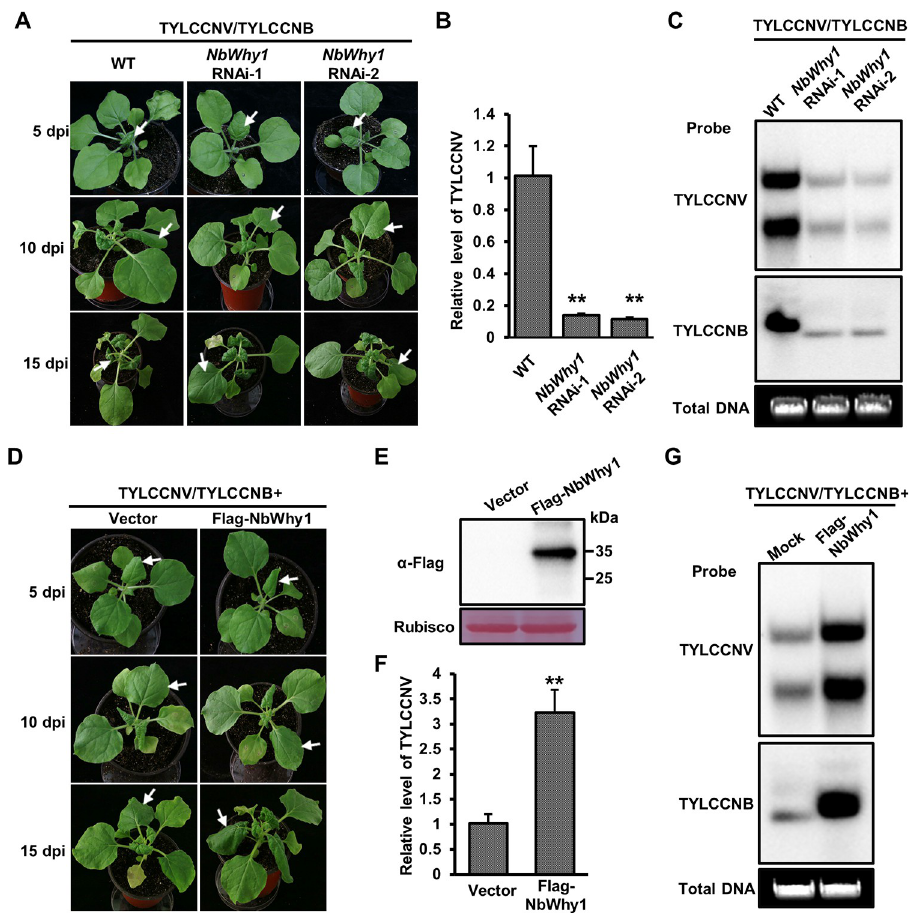
Fig 4. NbWhy1 negatively regulates plant defense against TYLCCNV/TYLCCNB. (A) Symptoms of the TYLCCNV/TYLCCNB-inoculated wild-type (WT) and NbWhy1 RNAi N . benthamiana plants at 5, 10, and 15 dpi, respectively. (B) qPCR analysis of the relative accumulation of TYLCCNV DNA in the plants shown in (A) at 10 dpi. (C) Southern blot analysis of viral DNA accumulation in the systemic leaves of the inoculated plants as shown in (A) at 10 dpi. The Gelstain-stained agarose gel serves as a loading control. (D) Effect of the transient overexpression of NbWhy1 on the symptoms induced by TYLCCNV/TYLCCNB. N . benthamiana plants were inoculated with TYLCCNV/TYLCCNB and Flag-NbWhy1 or TYLCCNV/TYLCCNB and pCambia-Flag (the vector control) and symptoms were monitored and recorded at 5, 10 and 15 dpi, respectively. (E) Western blot analysis of the expression of Flag-NbWhy1 in the infiltrated leaf samples at 48 hours post infiltration (hpi). (F) qPCR analysis of the relative accumulation of TYLCCNV DNA in the plants shown in (D) at 10 dpi. (G) Southern blot analysis of viral DNA accumulation in the systemic leaves of the inoculated plants as shown in (D) at 10 dpi. White arrows indicate different severity of the corresponding leaves. 25S rRNA was used as an internal control of qPCR. Mean and standard deviation of four independent plants are shown. Double asterisks indicates a significant statistical difference between two treatments at p < 0.01 based on Student’s t test. The Gelstain-stained agarose gel serves as a loading control.